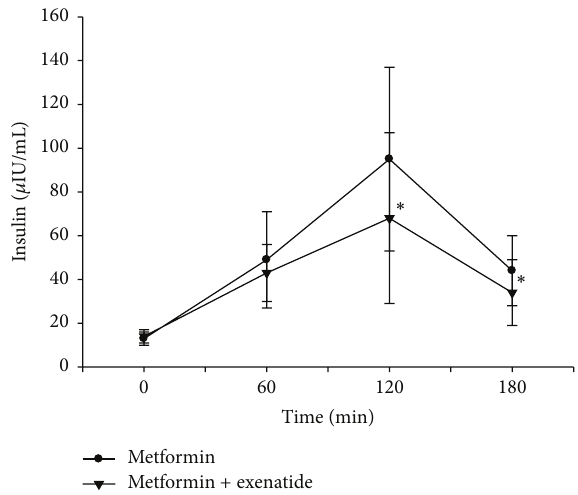
Figure 2: Serum insulin levels following mixed meal test with and without exenatide usage. ∗ 𝑝 < 0.05 when the percentage changes in serum insulin levels of two treatments were compared.